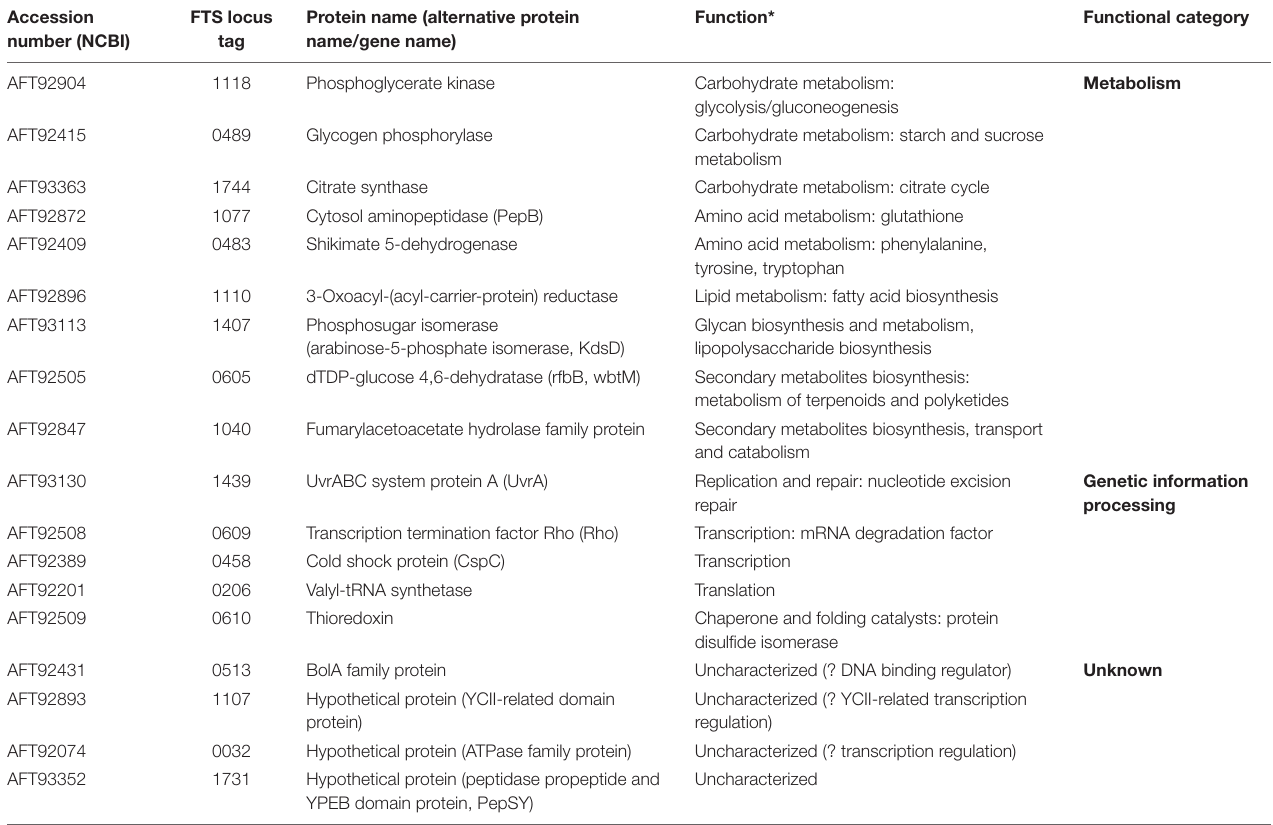
TABLE 1 | Candidate GapA interaction partners identified by SILAC-AP-MS/MS